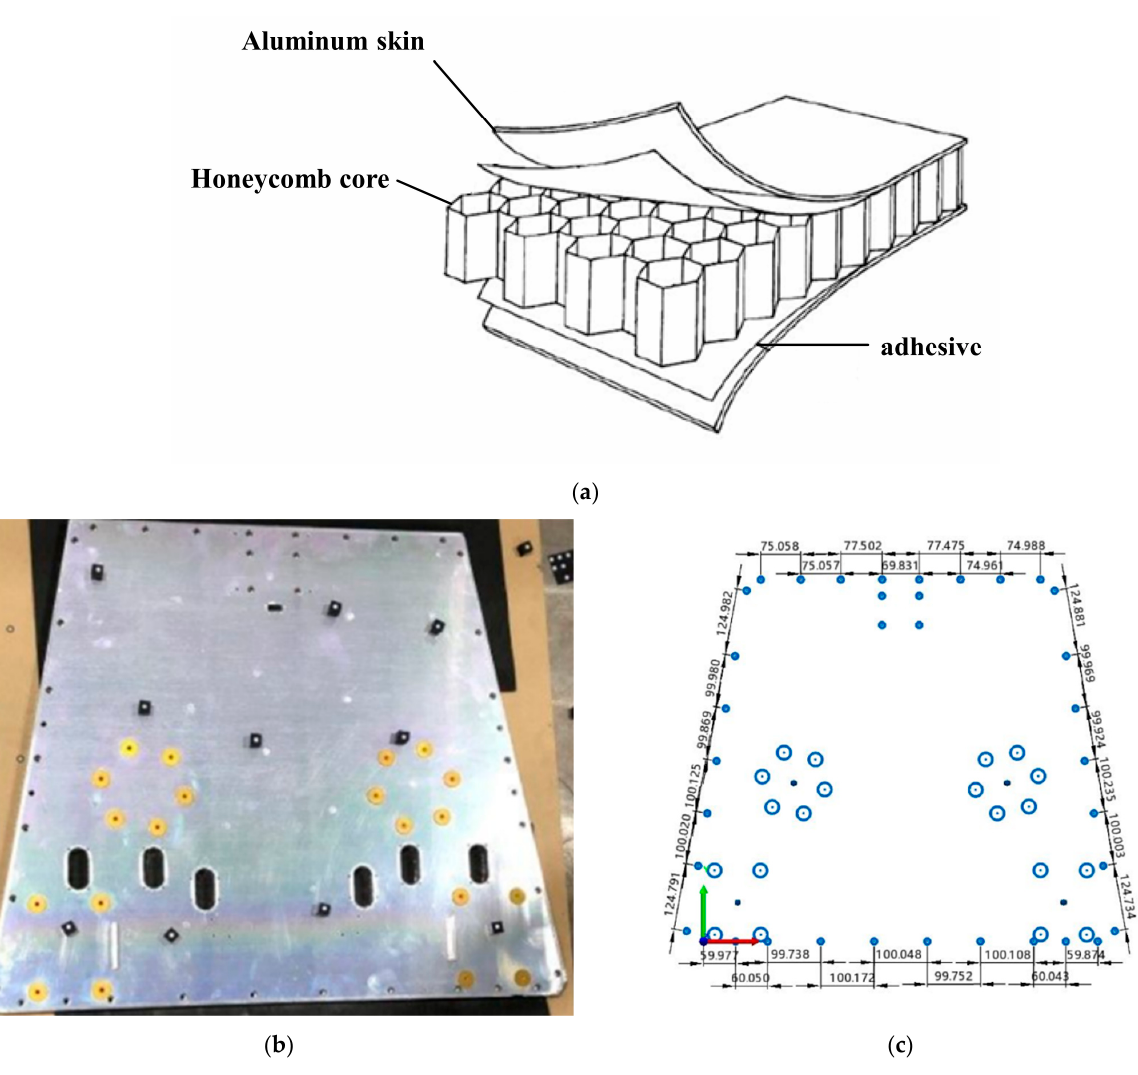
Figure 7. Honeycomb panel and dimensions ( a ) inner structure ( b ) schematic diagram ( c ) physical appearance.